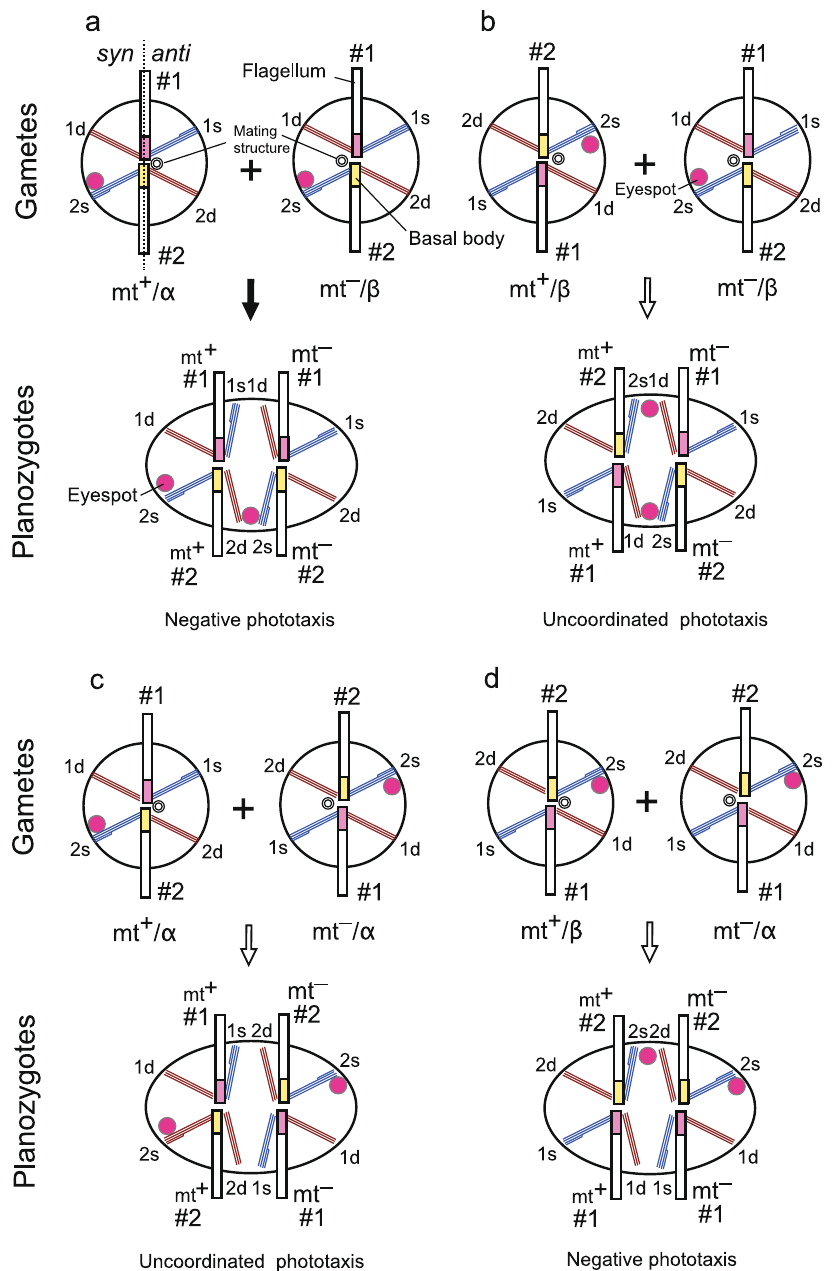
Fig. 6 Schematic diagrams of possible gamete fusion patterns of C. reinhardtii . a Gamete fusion pattern in C. reinhardtii . b If the mt + gamete has a mating structure on the same side of the eyespot as the beat plane, the eyespots are distributed on both sides of the cell after fusion with the normal mt – gamete. c If the mt – gamete has a mating structure on the side of the beat plane opposite the eyespot, the eyespots are distributed on each side of the beat plane after fusion with the normal mt + gamete. d If mt + and mt – gametes have a mating structure on the same or opposite side of the beat plane as the eyespot, respectively, the eyespots are aligned on the same side of the cell after gamete fusion. This is a reverse case of a . All cells were viewed from the cell anterior. Predicted outcomes of planozygote phototaxis are shown below the diagrams. #1 : no. 1 fl agellum, #2 : no. 2 fl agellum, 1d , 1s , 2d and 2s : 1d, 1s, 2d and 2s microtubular roots, respectively, α : type α , β : type β